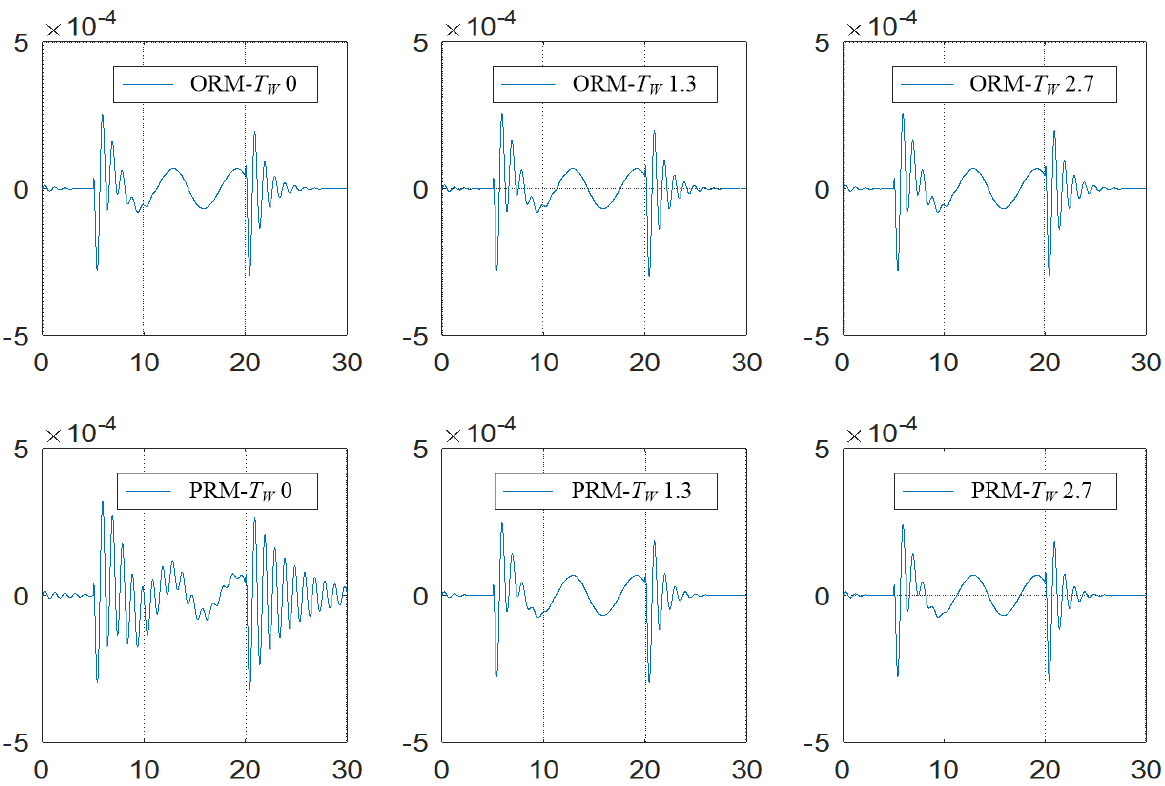
Figure 13. Response of rotor speed deviation x under voltage fluctuation.